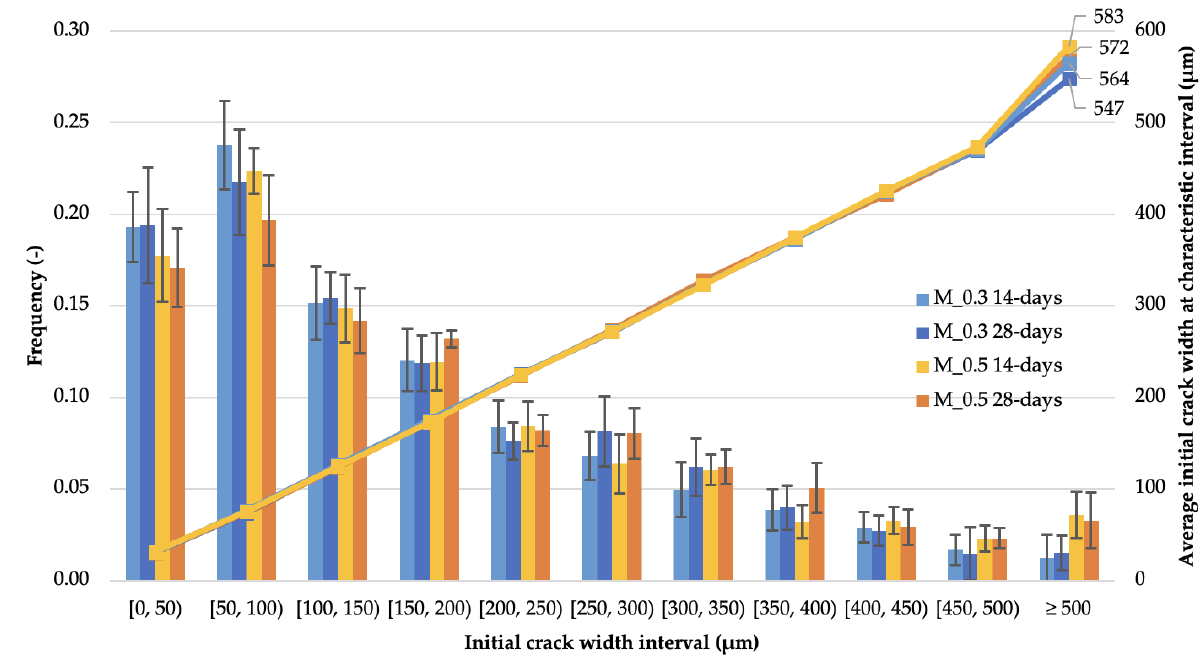
Figure 5. Frequency of crack widths and average initial crack widths analyzed within the width intervals; the intervals ± standard deviation show the variation in crack width frequency within the mortar groups.